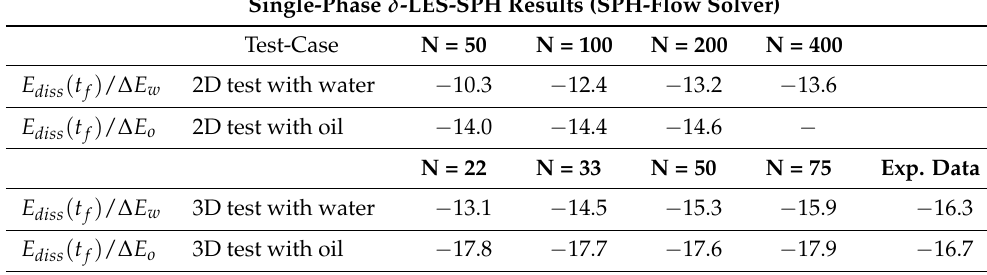
Table 1. Total energy fluid dissipation, E diss ( t f ) for 2D/3D SPH simulations with water and with oil using different spatial resolution N = H / ∆ x . Numerical outputs are compared with the experimental data of [4]. The 2D results are ensemble averages of ten different simulations, while 3D simulations are given by single